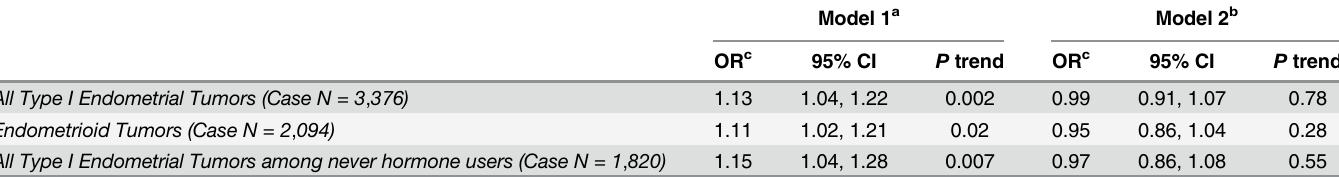
Table 2. Body Mass Index Genetic Risk Score and Endometrial Cancer Risk Among Women of European Ancestry.